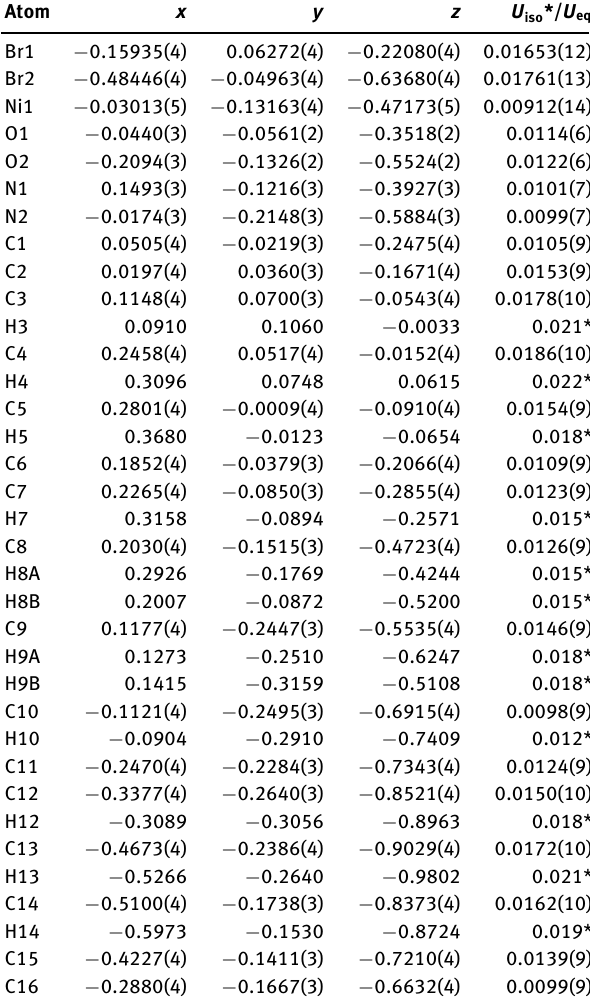
Table 2: Fractional atomic coordinates and isotropic or equivalent isotropic displacement parameters (Å 2